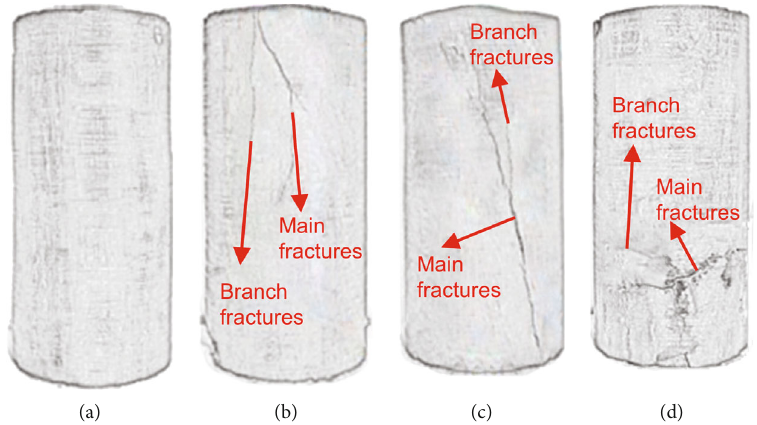
Figure 11: Geological sketches of the basalts (a) before irradiation and after exposed at (b) 1kW, (c) 3kW, and (d) 5kW for 20